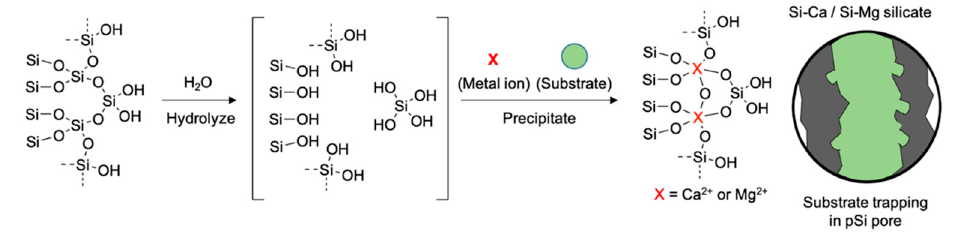
Figure 9. Schematic illustration of the calcium (Ca 2+ )- or magnesium (Mg 2+ )-silicate formation of